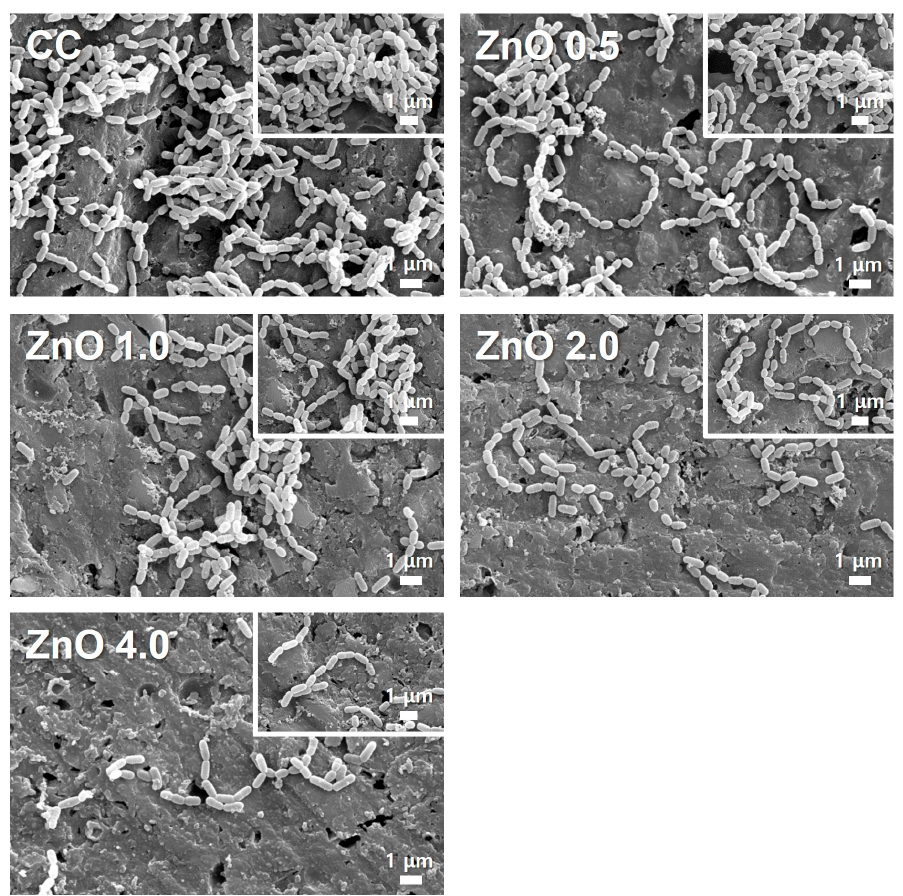
Figure 3. Scanning electron microscopy images of S. mutans attached to the surface of the experimental materials with/without ZnO NPs at magnifications of 10,000 × ( top ) and 5000 × ( bottom